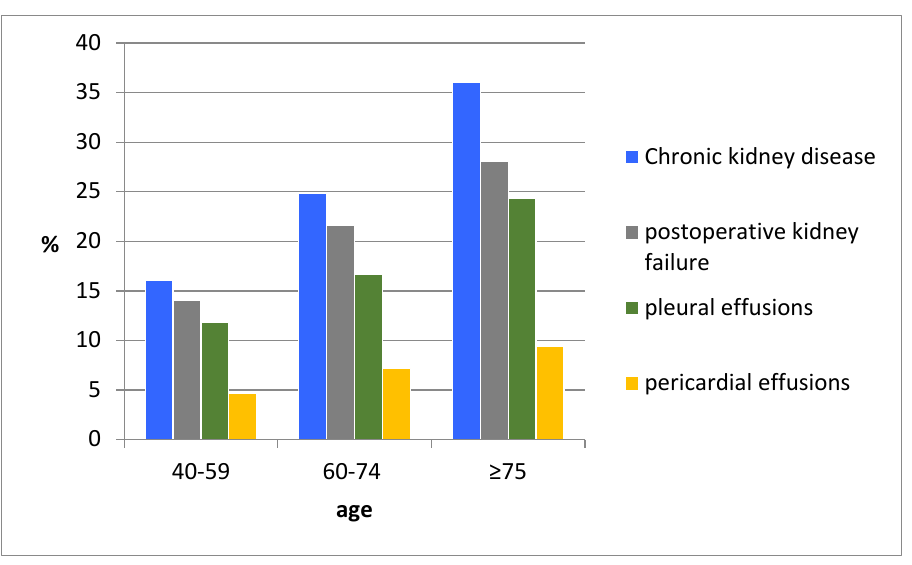
Figure 1. Age ‐ related complication Figure 1. Age-related complication.